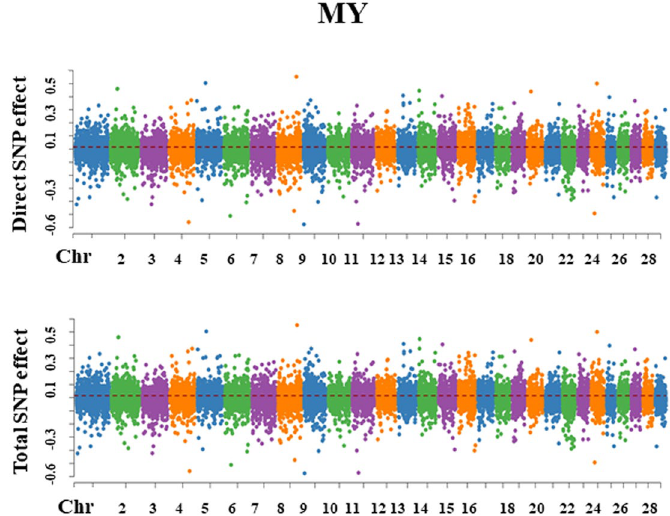
Figure 3. Manhattan plots for SNP effects on milk yield obtained using SEM-GWAS based on the network structure learned by Hill-Climbing algorithm. MY: milk